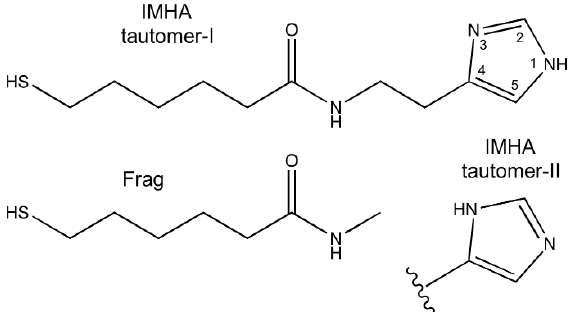
Figure 1. Chemical structures of N-(2-(1H-imidazol-4-yl)ethyl)-6-mercaptohexanamide (IMHA) and 6-mercapto-N-methylhexanamide (molecular fragment, Frag). Atom numbering indicated for imidazole ring. Two tautomeric forms of imidazole are shown.